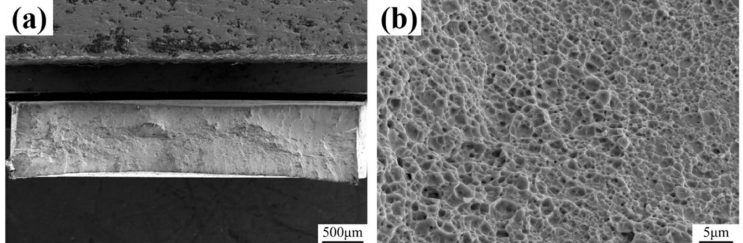
Figure 8. SEM images of the uncharged specimens: ( a ) overview of fracture surface, and ( b ) dimple morphology.